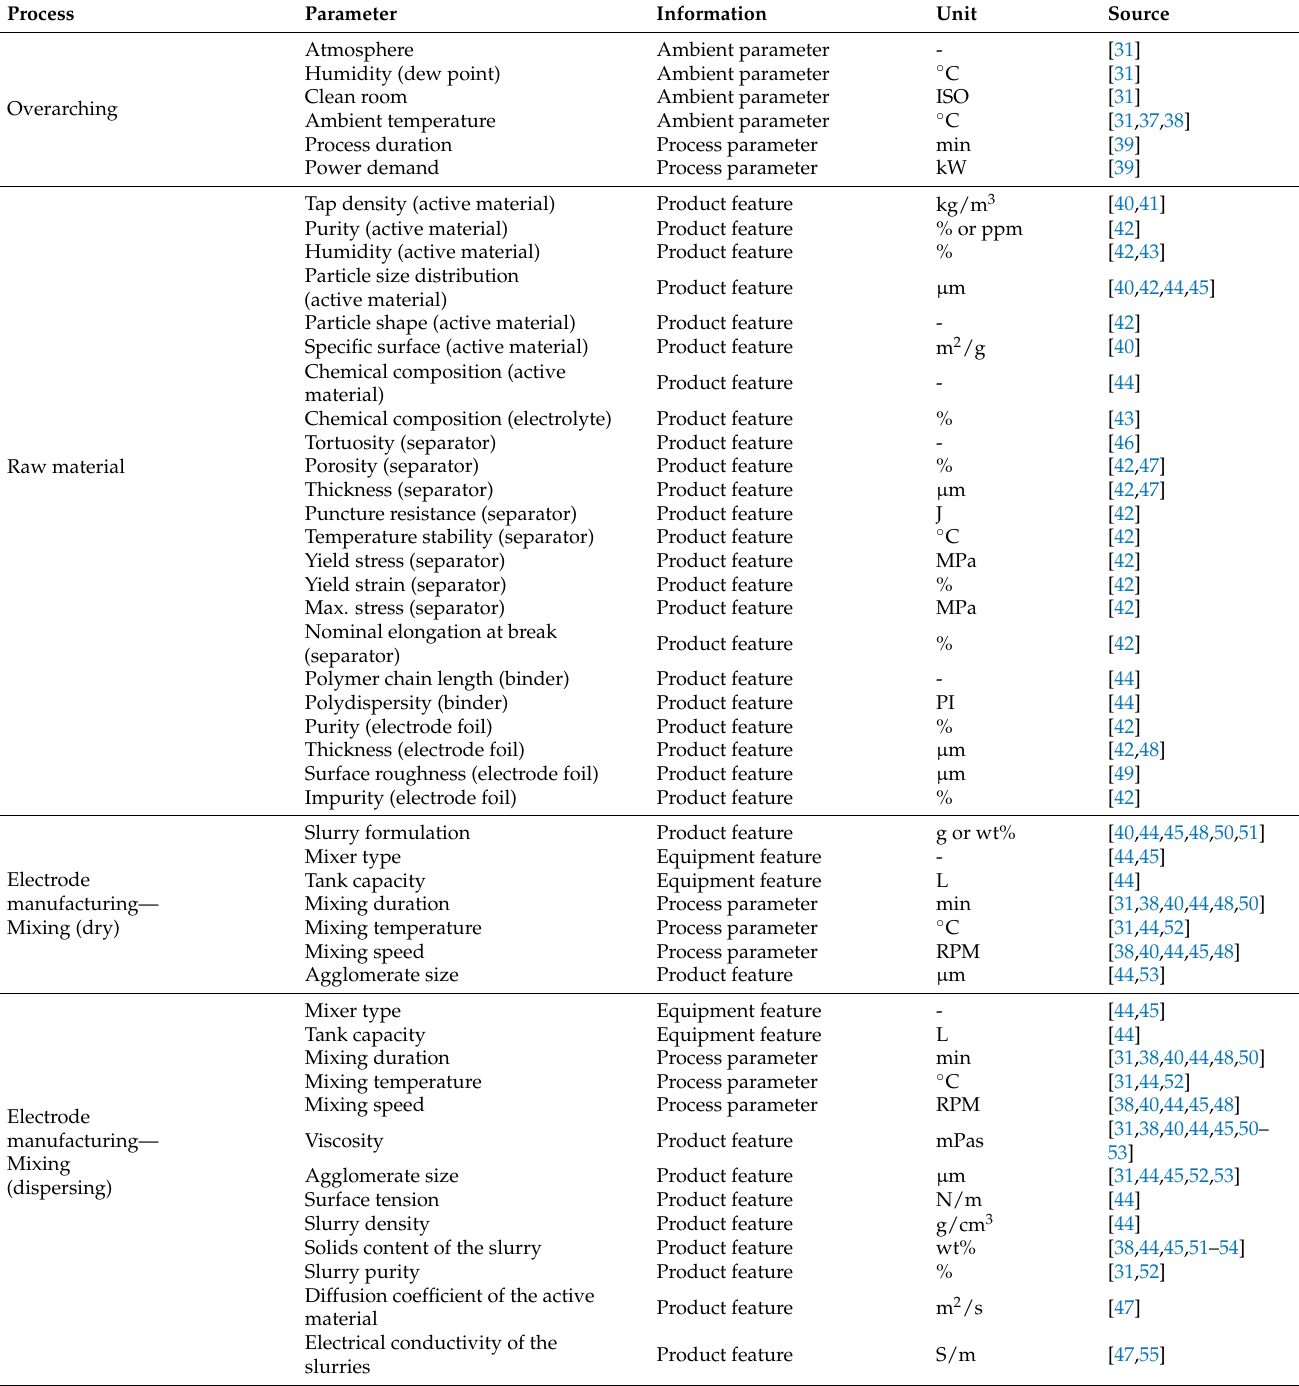
Table A1. Overview of battery cell production parameters for a pouch